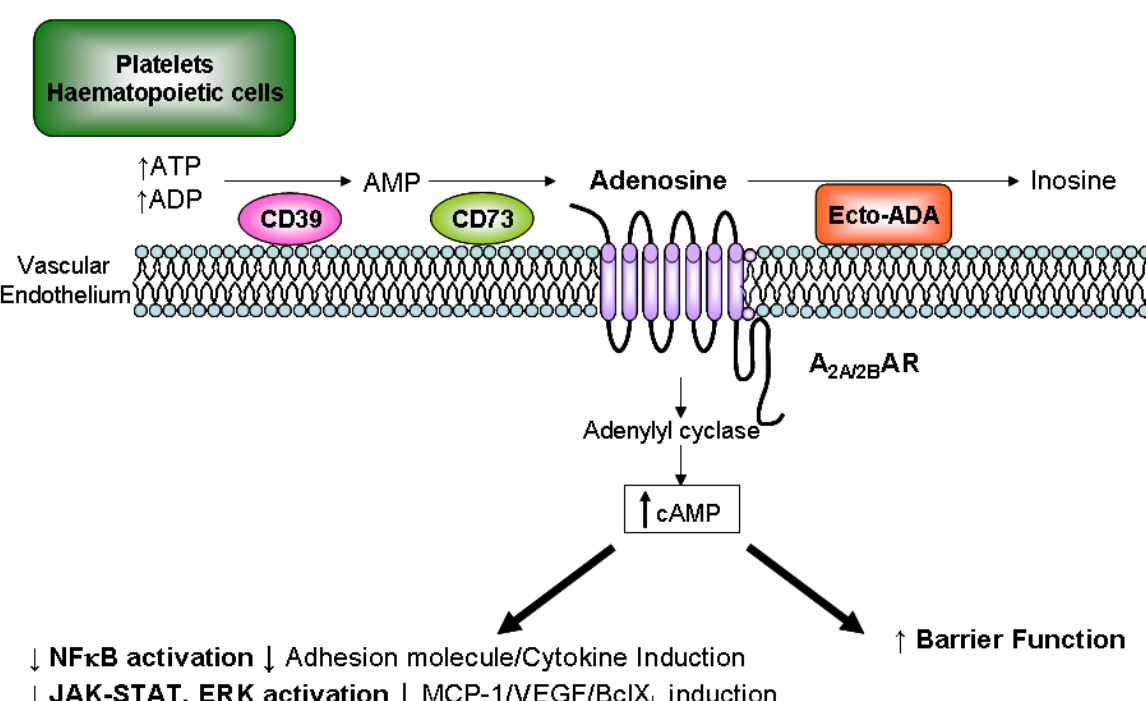
FIGURE 1. Interaction of extracellular adenine nucleotide metabolism with adenosine receptor signalling at the vascular endothelium. An increase in the release of ATP and ADP from endothelial cells, platelets, and haematopoietic cells under conditions of hypoxia, stress, or inflammation leads to its hydrolysis by ecto-apyrase CD39 to AMP, which is then converted to adenosine by the ecto-5’-nucleotidase CD73, both of which are abundantly expressed on the surface of the vascular endothelium. Adenosine can then bind and activate A and 2A A ARs expressed on vascular endothelial cells. While both receptors are typically expressed in endothelial cells, 2B the A AR displays a higher affinity for the endogenous agonist adenosine and will thus be activated at lower 2A agonist concentrations than the A AR. Both receptors can couple positively to adenylyl cyclase to elevate 2B intracellular levels of cAMP. This triggers a plethora of protective effects via its intracellular sensors PKA and EPAC1: these include the inhibition of proinflammatory NFκB and JAK/STAT signalling pathways, and the enhancement of endothelial barrier function. These responses are largely transient in nature due at least in part to the ability of ecto-ADA to promote the deamination of adenosine to inosine, which is inactive at A and A ARs. 2A 2B in PKA-mediated activation of ERK via Src kinases[17]. Conversely, in endothelial cells and HEK293 cells, ERK can be activated independently of G and cAMP elevation, and requires Ras[18,19]. The s A AR can also recruit the Arf6 guanine nucleotide exchange factor (GEF), ARNO, which is required for 2A sustained A AR-mediated activation of the ERK pathway in HEK293 cells[20]. 2A